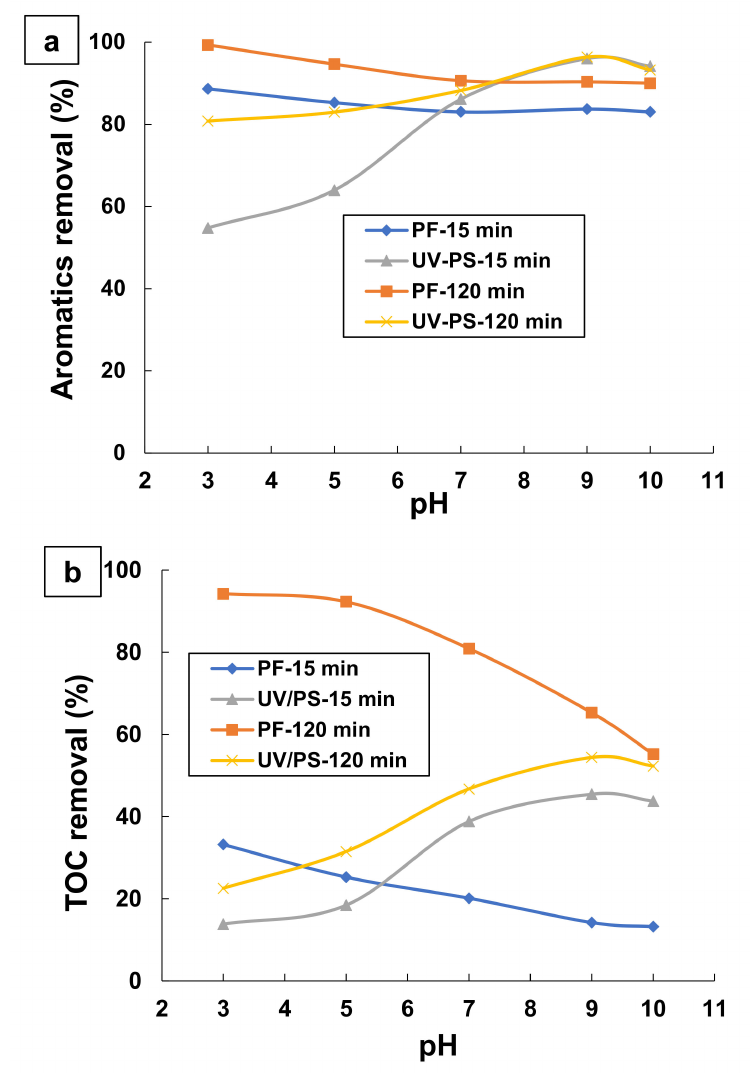
Figure 4. Influence of initial pH on the changes of: ( a ) aromatics removal, and ( b ) TOC removal, during the treatment of 0.1 mM TA by UV/PS and UV/H 2 O 2 /Fe 2+ processes. Experimental conditions: (UV/PS: [K 2 S 2 O 8 ] = 53.1 mM, pH = 3–10 and T = 25 ◦ C; UV/H 2 O 2 /Fe 2+ : [H 2 O 2 ] = 29.4 mM, [Fe 2+ ] = 0.18 mM, pH = 3–10, and T = 25 ◦